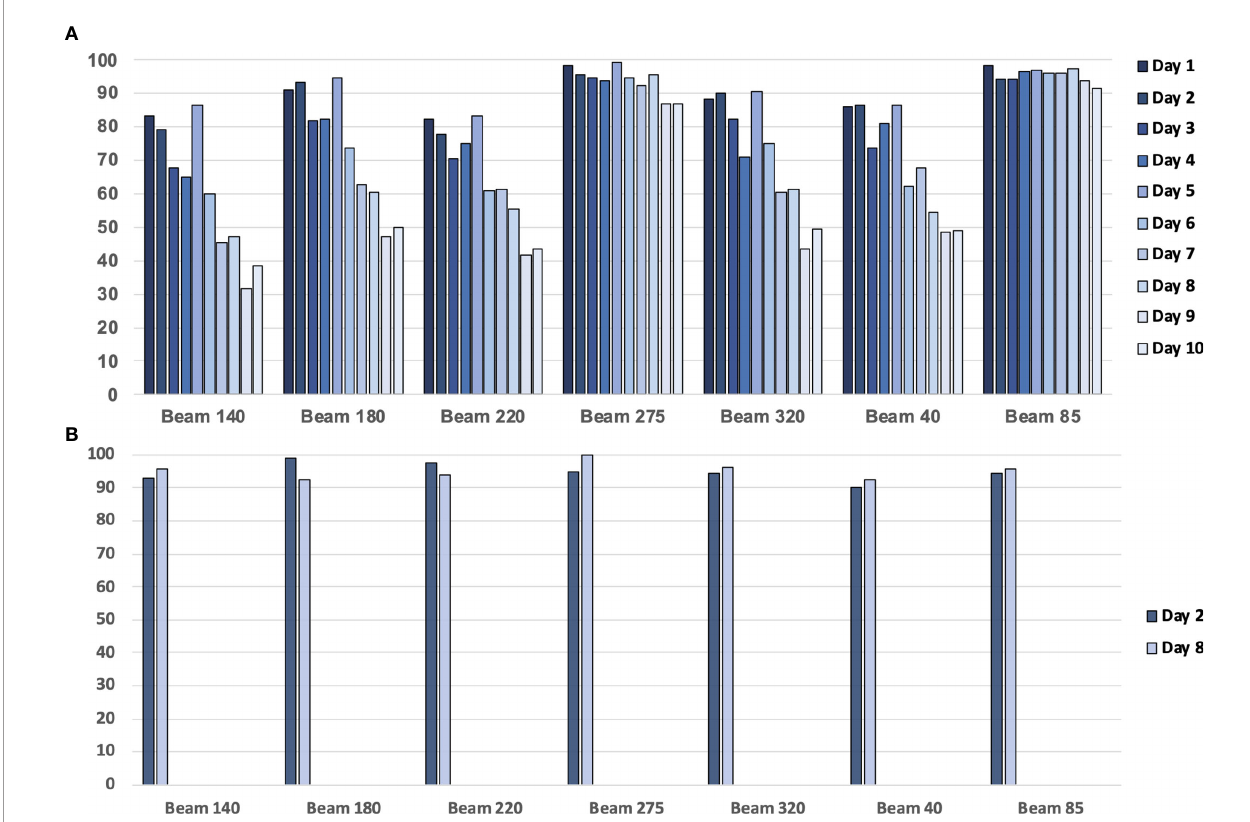
FIGURE 12 | (A) The gamma passing rate (3 mm, 3%) between the planning CT (pCT)-based calculated dose and measured dose for a patient with 10 treatment fractions. (B) The gamma passing rate (3 mm, 3%) between the daily CT (dCT)-based calculated dose and measured dose for a